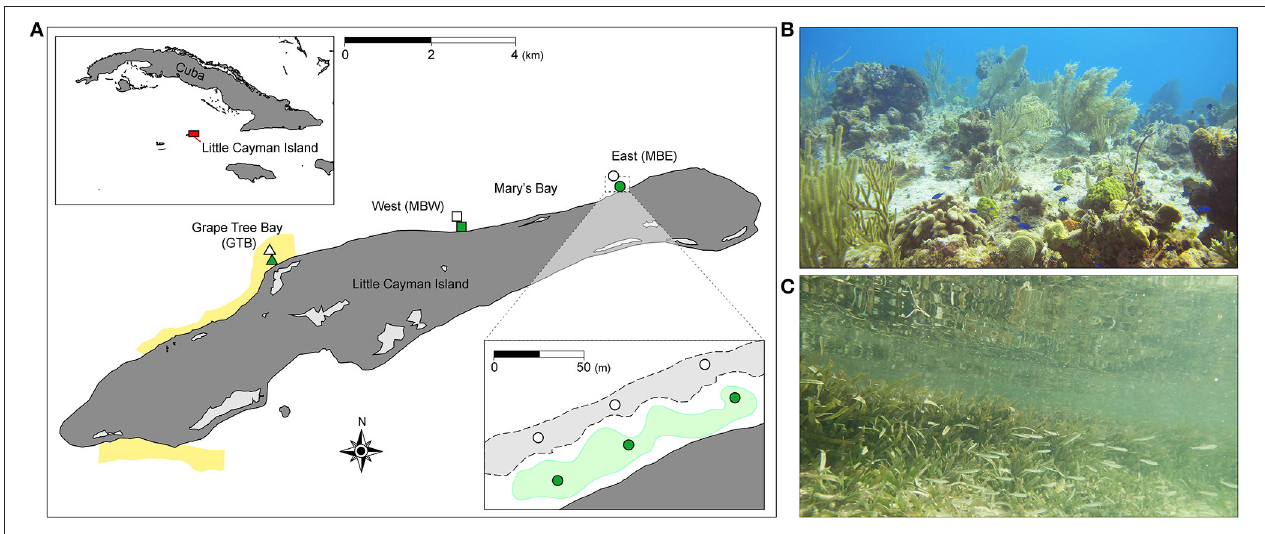
FIGURE 1 | Study sites on Little Cayman Island. Map of Little Cayman Island (A) located within the Caribbean Sea (upper inset), yellow highlighting denotes the location of marine parks. Three locations, Mary’s Bay East ( MBE, circles ) and West ( MBW, squares ), and Grape Tree Bay ( GTB, triangles ) were chosen as study sites. Back-reef (light gray areas with dashed lines, lower inset) and seagrass (green areas, lower inset) sites were selected within each study location ( n = 3 per site spaced 50m apart, lower inset ). Typical benthic scenes are indicated for back-reef and seagrass sites in (B,C) , respectively. The base data for the map (A) were collected from www.openstreetmap.org ( © OpenStreetMap contributors) under the Open Database License and customized in Adobe Illustrator (version